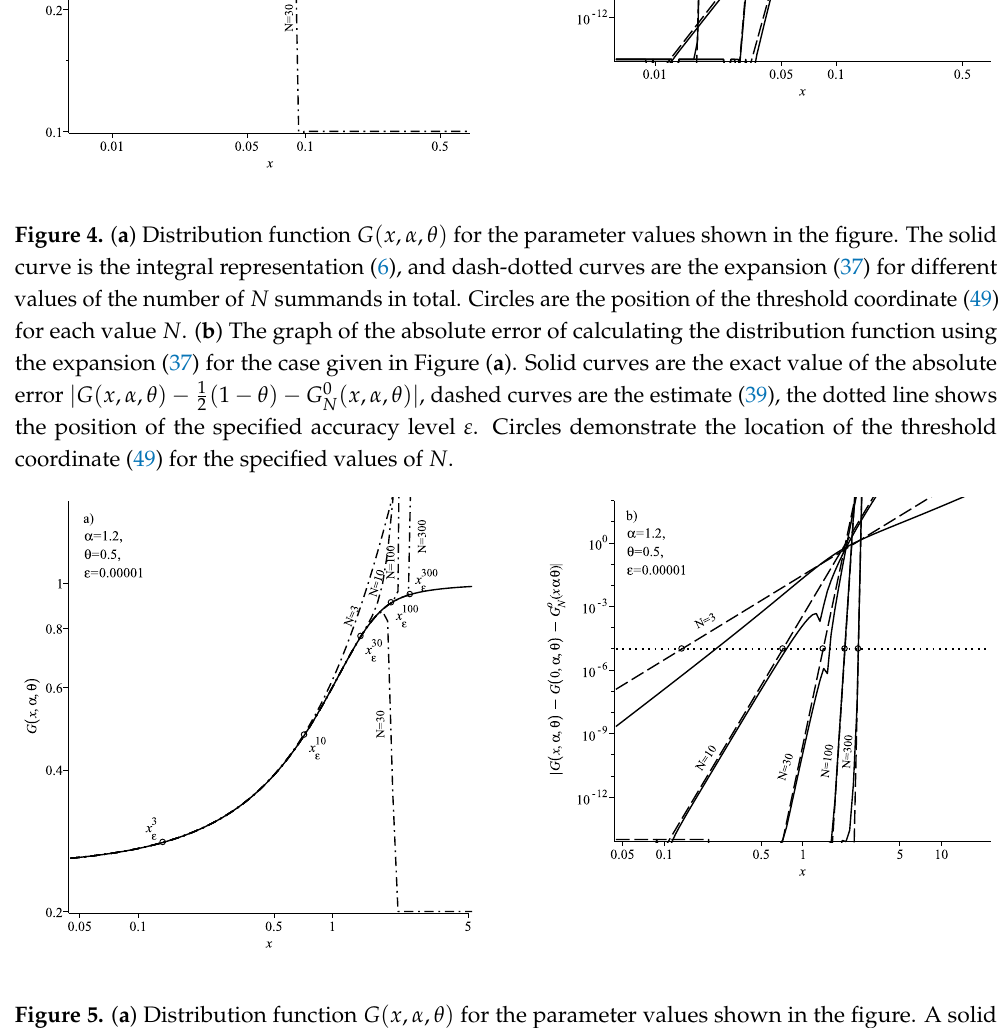
Figure 5. ( a ) Distribution function G ( x , α , θ ) for the parameter values shown in the figure. A solid curve is the integral representation (6), and dash-dotted curves are the expansion (37) for different values of the number of N summands in total. Circles are the position of the threshold coordinate (49) for each value of N . ( b ) The graph of the absolute error of calculating the distribution function using the expansion (37) for the case given in Figure ( a ). Solid curves are the exact value of the ( 1 − θ ) − G 0 ( x , α , θ ) | , dashed curves are the estimate (39), the dotted absolute error | G ( x , α , θ ) − 1 N 2 line shows the position of the specified accuracy level ε . Circles demonstrate the location of the threshold coordinate (49) for the specified values of N